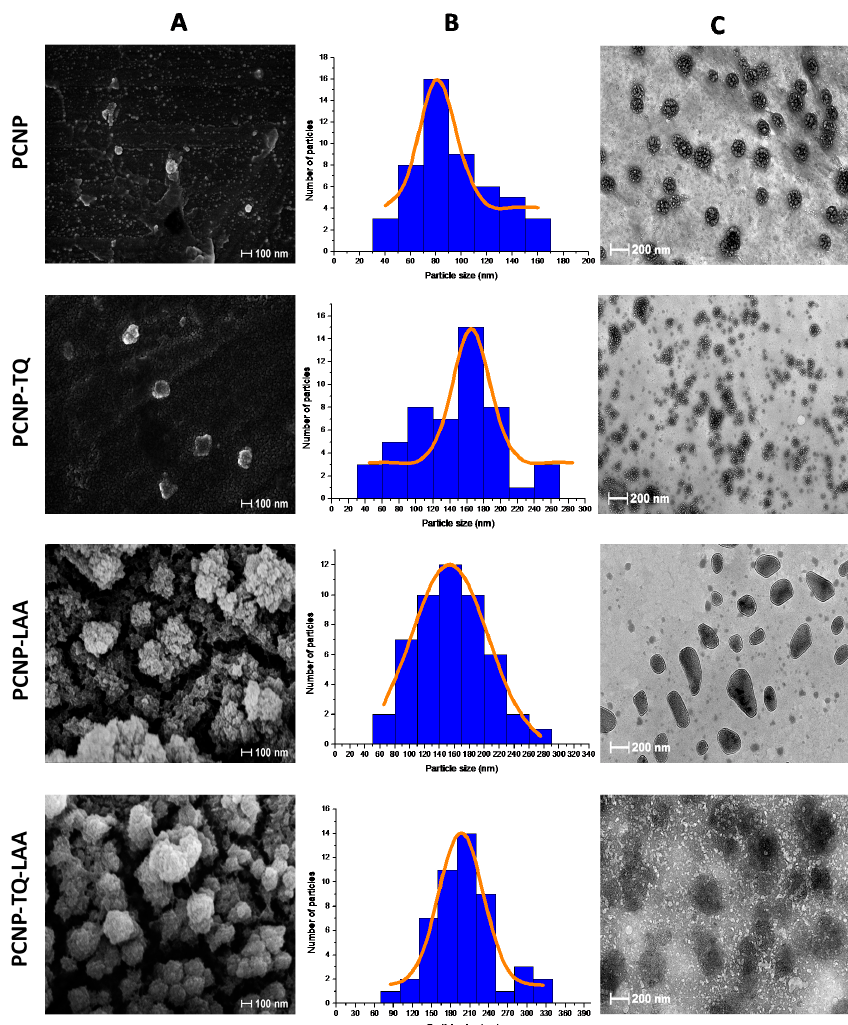
Figure 7. Field-emission scanning electron microscopy (FESEM) images (column A ), normal distribution of particles based on FESEM images (column B ) and high-resolution transmission electron microscopy (HRTEM) images (column C ) of PCNP, PCNP-TQ, PCNP-LAA and PCNP-TQ- (HRTEM) images (column C ) of PCNP, PCNP-TQ, PCNP-LAA and PCNP-TQ-LAA samples (from top LAA samples (from top to bottom row). Particle sizes increased as the encapsulated number of to bottom row). Particle sizes increased as the encapsulated number of antioxidant increased antioxidant increased (from empty PCNP to PCNP-TQ-LAA).